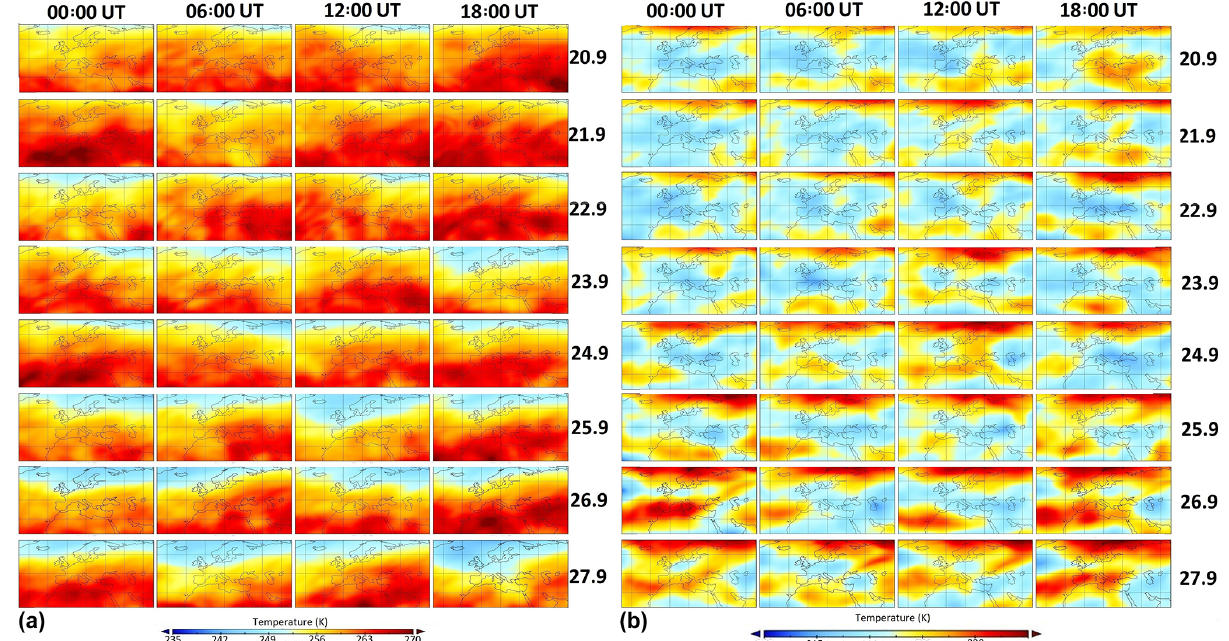
Figure 7. Stratospheric temperature above Europe at 1hPa ( a ; temperature in the range 235–270K) and at 0.1hPa ( b ; temperature in the range